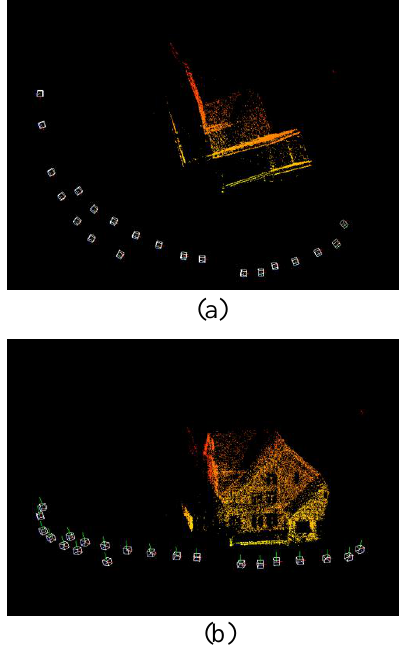
Figure 7. (a) A top-view and (b) a side-view of the Canon image dataset and the reconstructed sparse point